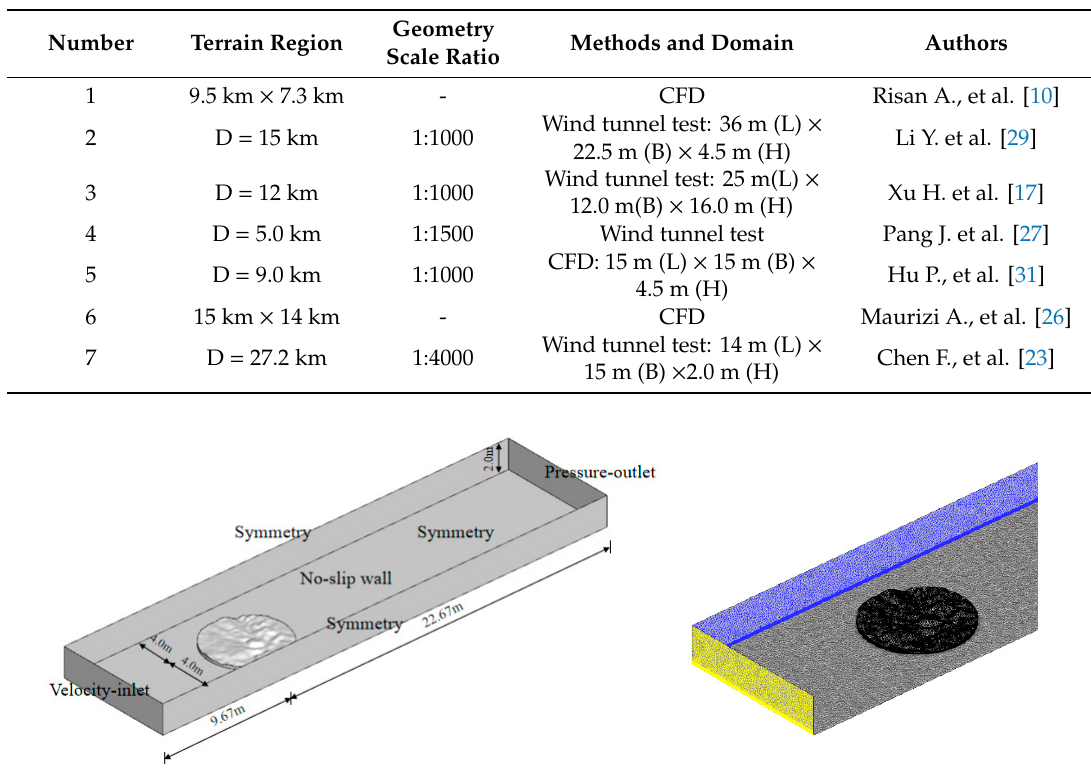
Figure 4. Computational domain, boundary conditions, and grid of terrain model without BTS.